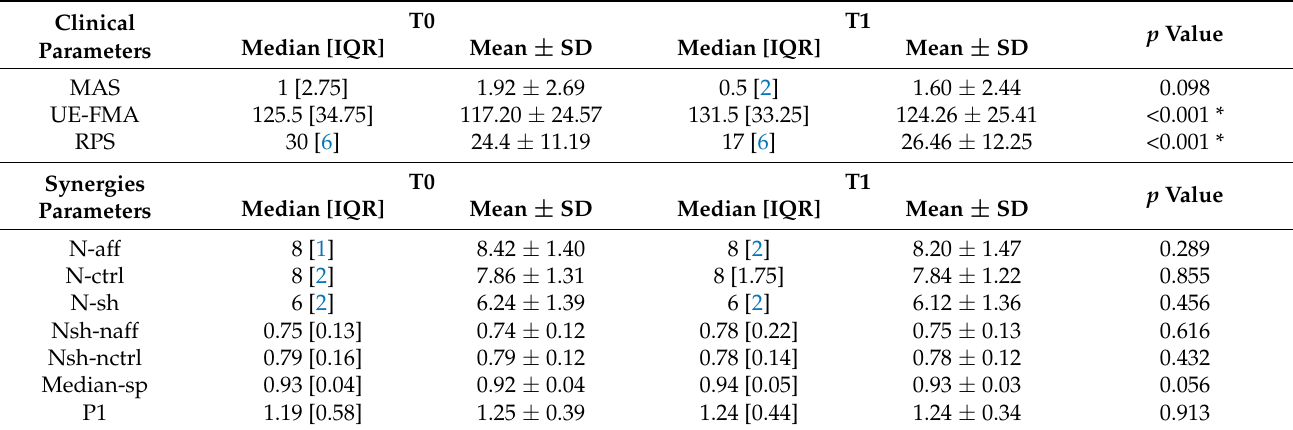
Table 2. Clinical outcomes and parameters related to synergies.